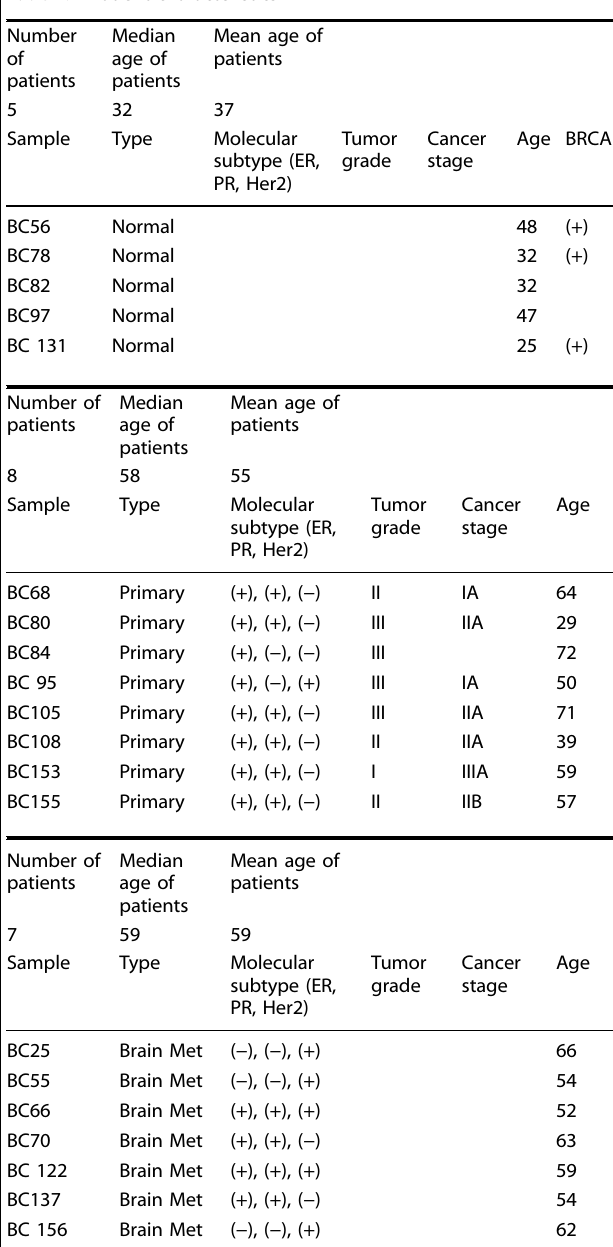
Table 1. Patient